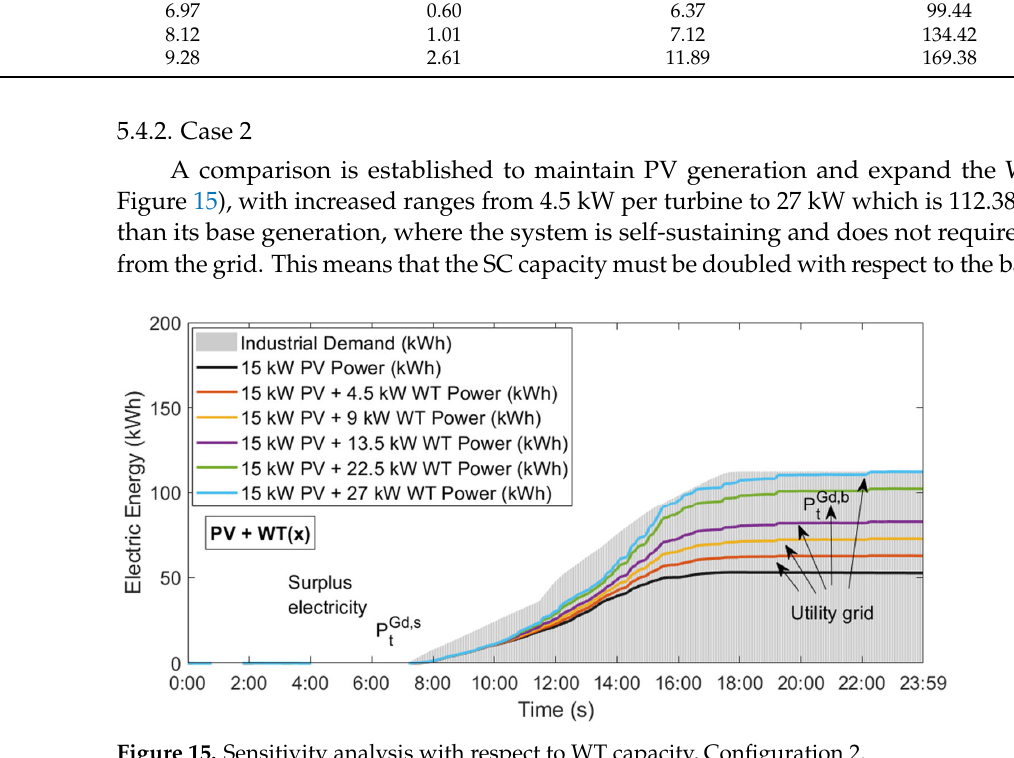
Figure 15. Sensitivity analysis with respect to WT capacity, Configuration 2.